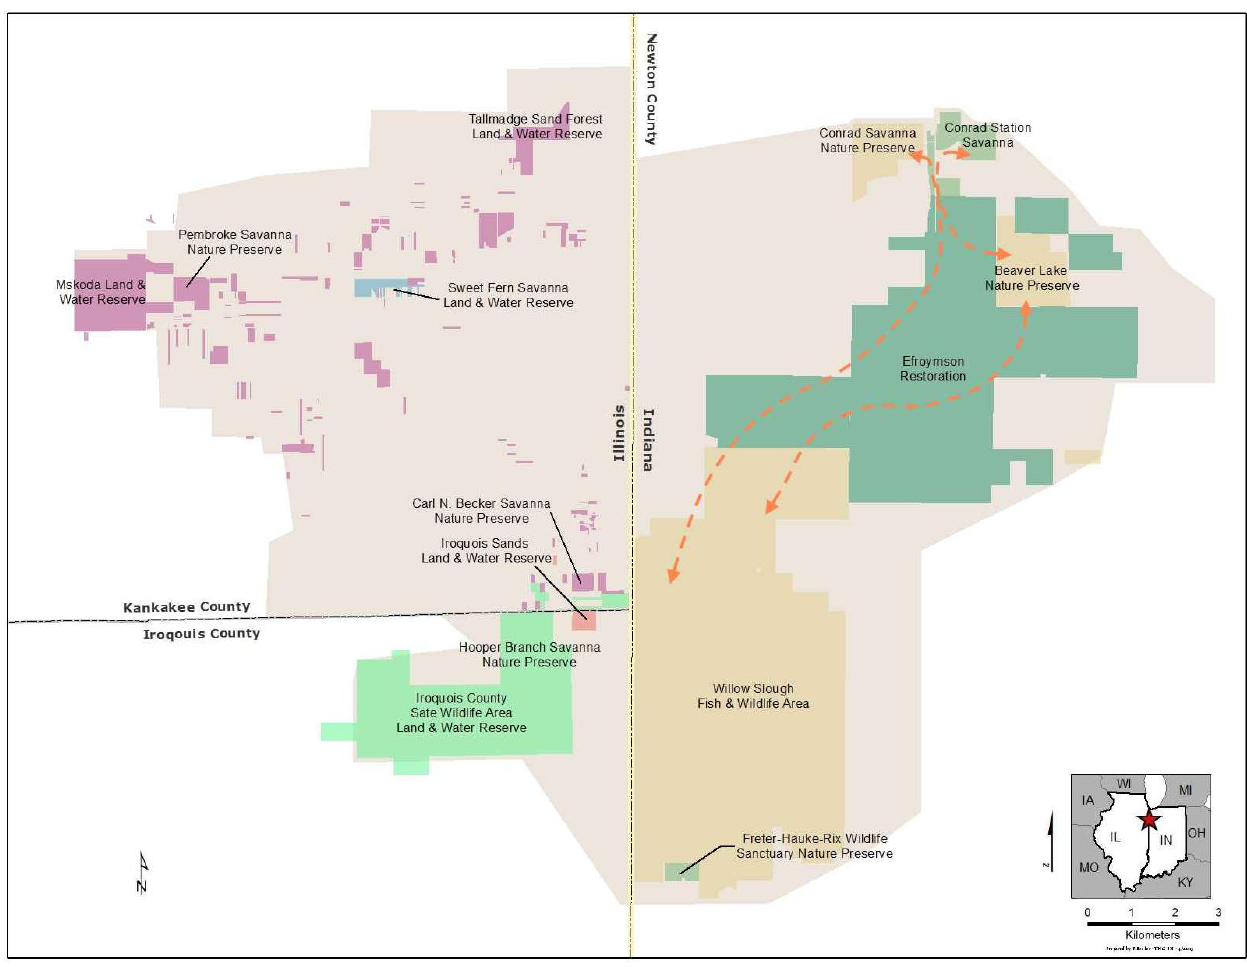
Figure 2. An overview of conservation lands at Kankakee Sands in Indiana and Illinois, USA. The Efroymson Restoration targeted agricultural lands that once restored, would restore connectivity between the primary Indiana Conservation